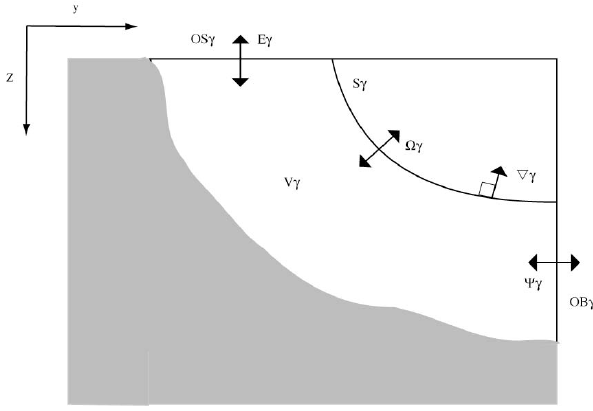
Fig. 5. Sketch of the ideal oceanic basin. We consider a limited area of the ocean with an open boundary . We denote S γ , the sur- face with neutral density γ over the limited domain; the volume V γ sandwiched between the isoneutral surfaces S γ , the ocean bottom and the ocean surface OS γ ; 9 γ and E γ the volume fluxes of fluid entering/exiting the domain V γ across the open boundary OB γ and surface, resp.; and (cid:127) γ , the total volume flux across the S γ (i.e. the dianeutral volume flux). The sign convention is that all the fluxes are positive if entering V γ